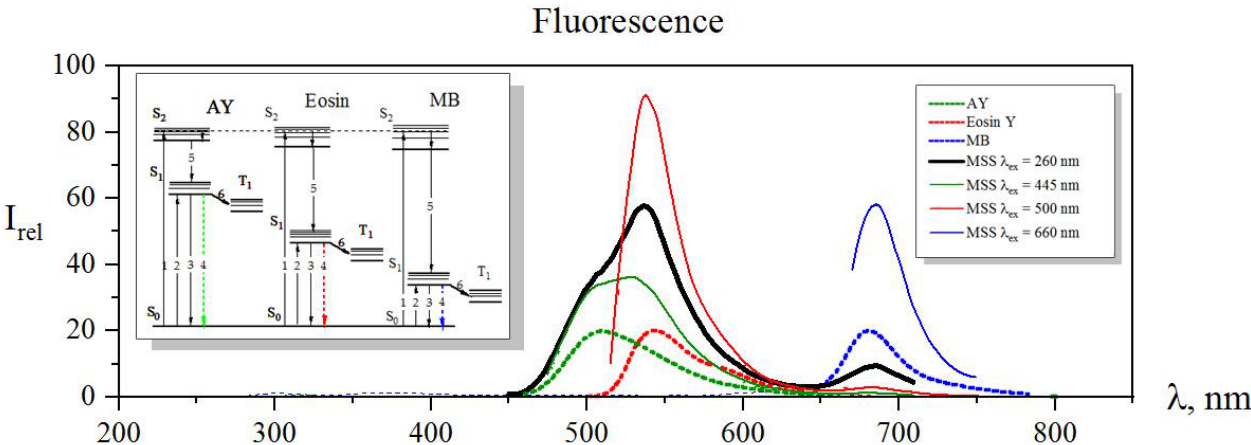
Figure 3. The fluorescence spectra of a fluorescent probe array under excitation at various wave- lengths of 260 nm (black solid line), 445 nm (green line), 500 nm (red line), and 660 nm (blue line). The dotted lines mark fluorescence spectra of acridine yellow (green dotted), eosin (red dotted), and methylene blue (blue dotted), normalized to I rel = 20. The insert is an energy diagram illustrating the photophysical processes taking place in the system.